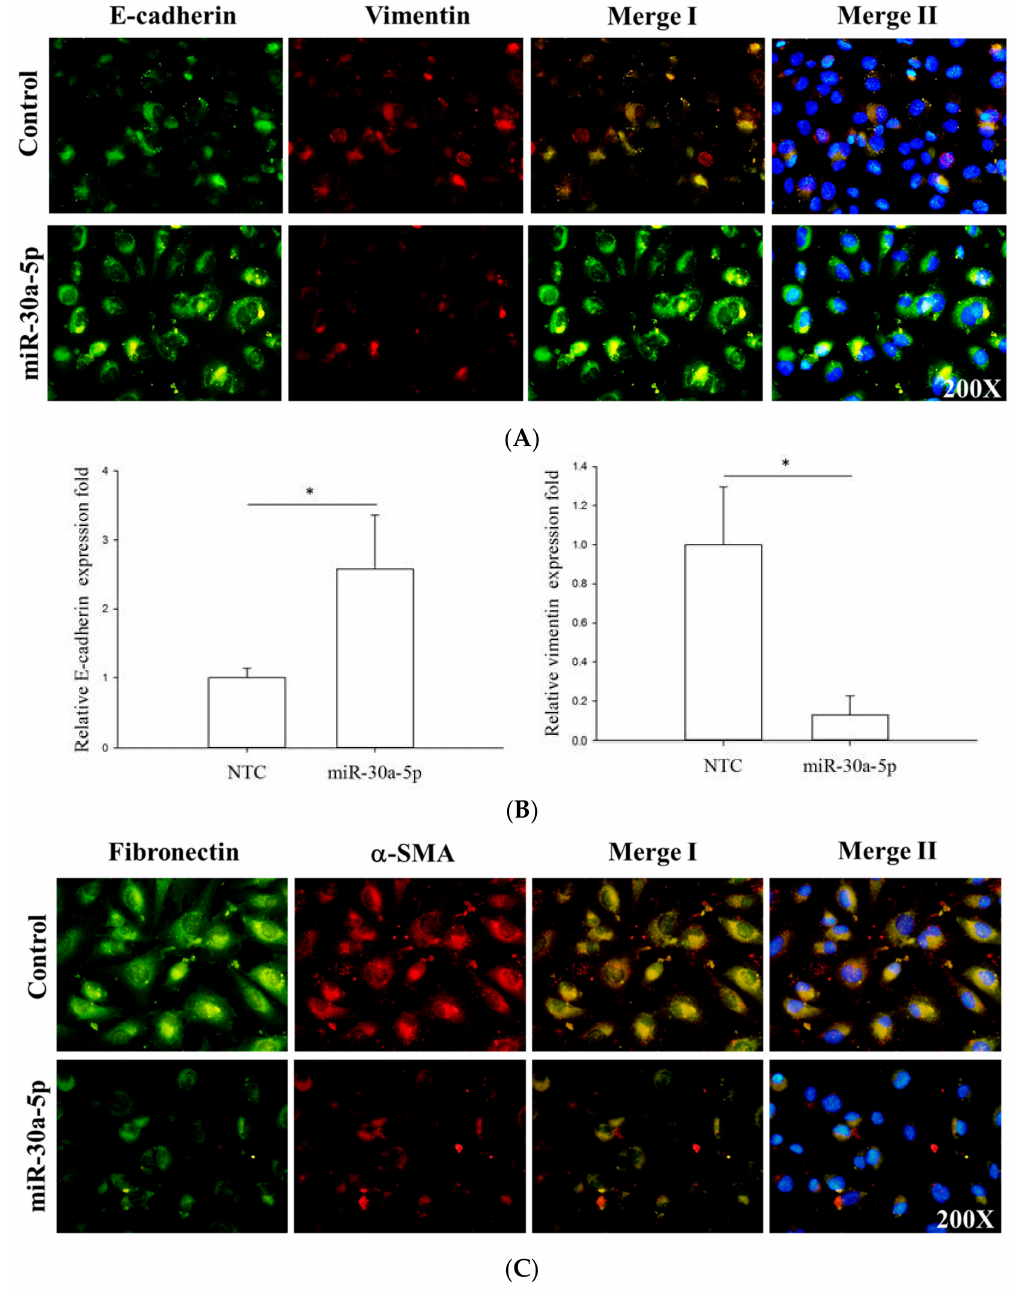
2.5. miR-30a-5p Overexpression Inhibits Epithelial-to-Mesenchymal Transition (EMT) in BFTC-909